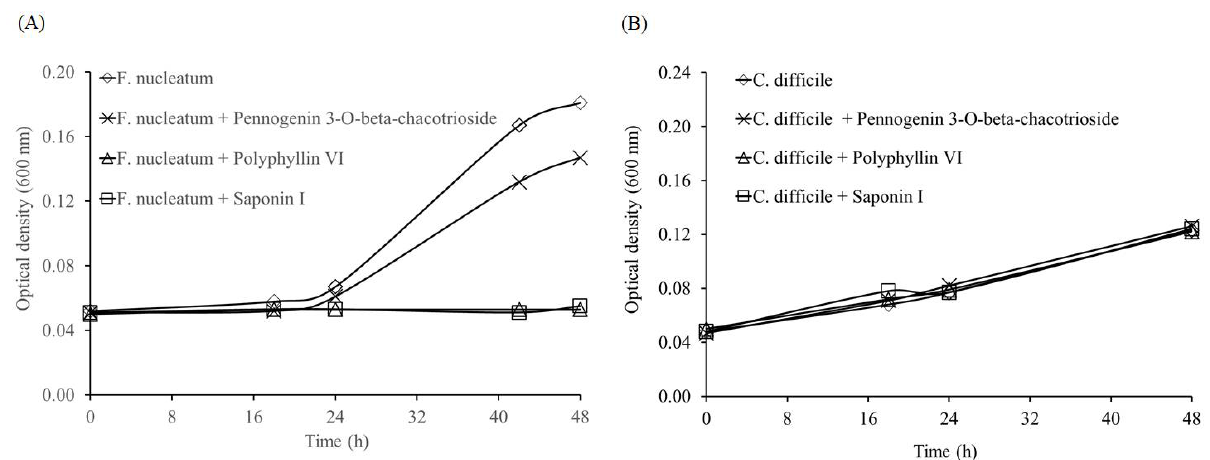
Figure 4. Effect of pennogenin 3- O -beta-chacotrioside, polyphyllin VI, and saponin I at 5 μM on the growth curve of ( A ) Fusobacterium nucleatum and ( B ) Clostridium difficile .